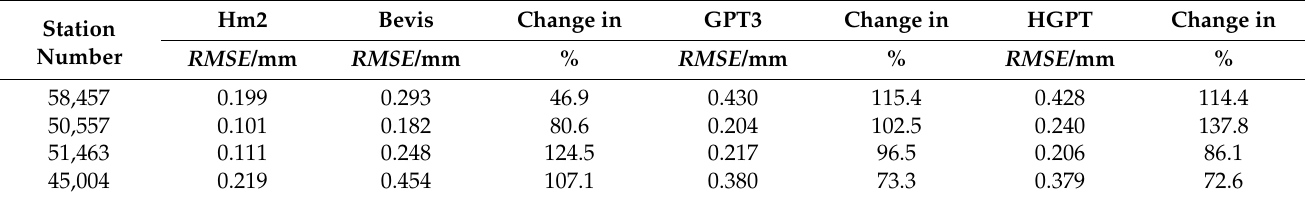
Table 7. The RMSE of the differences between the computed and the reference